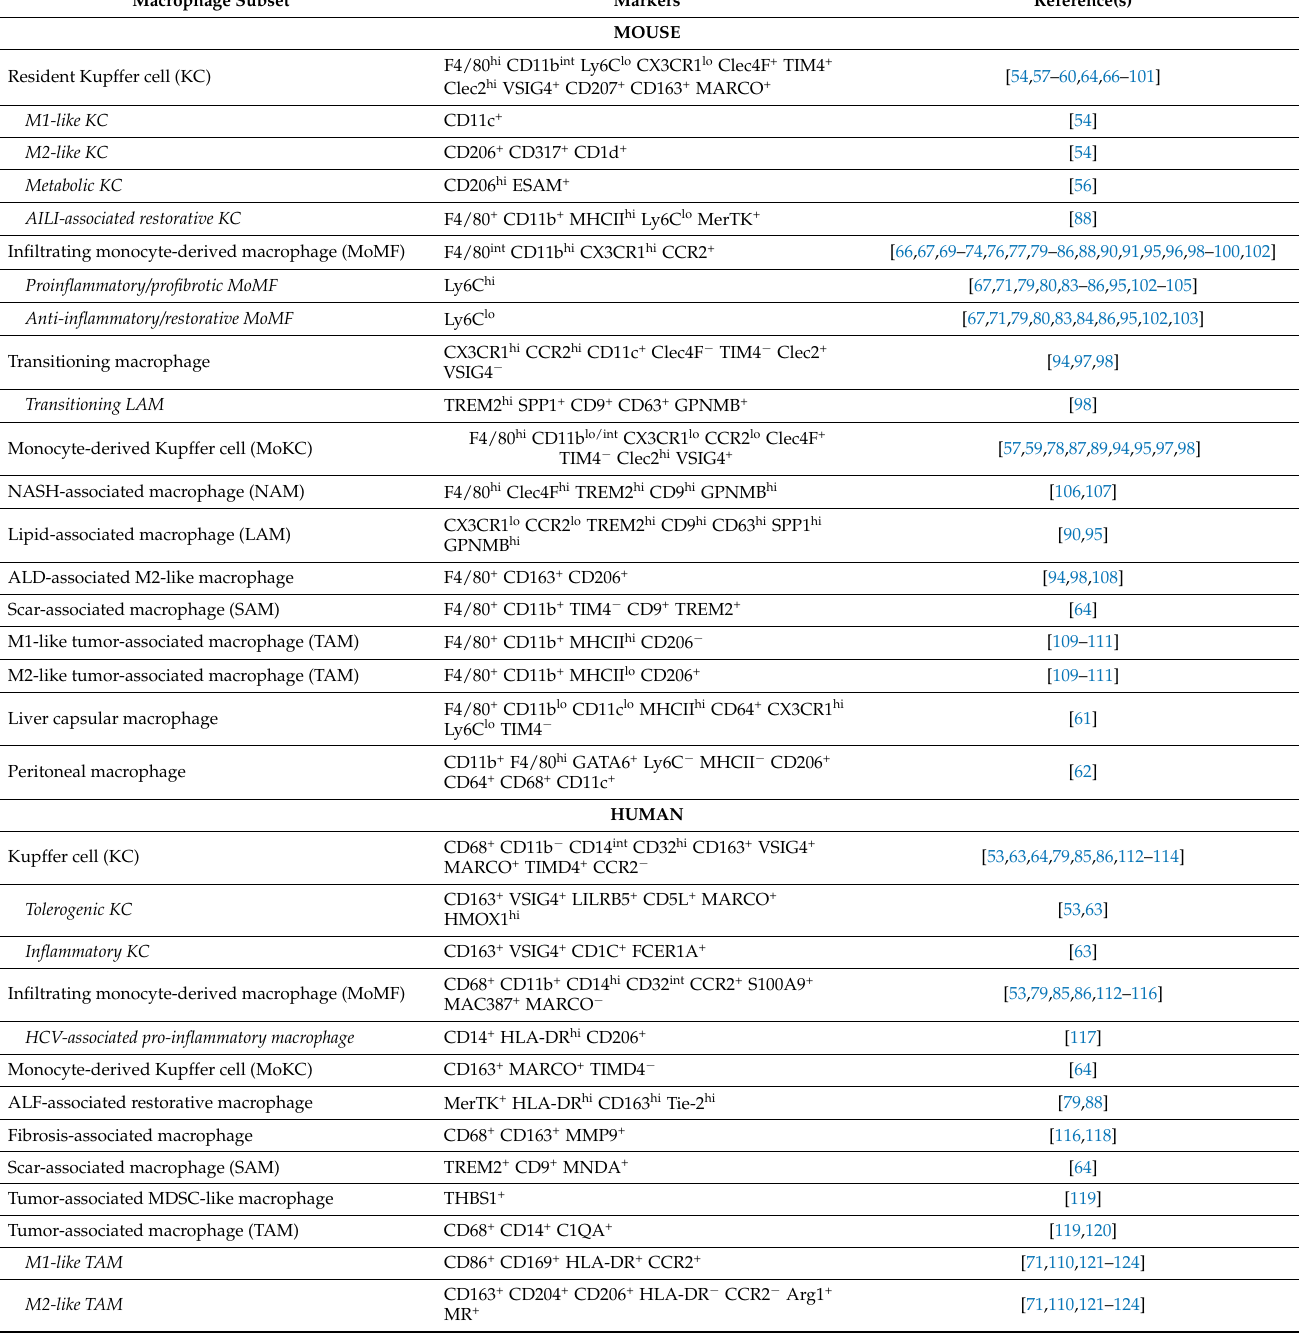
Table 2. Hepatic macrophage subsets in mouse and